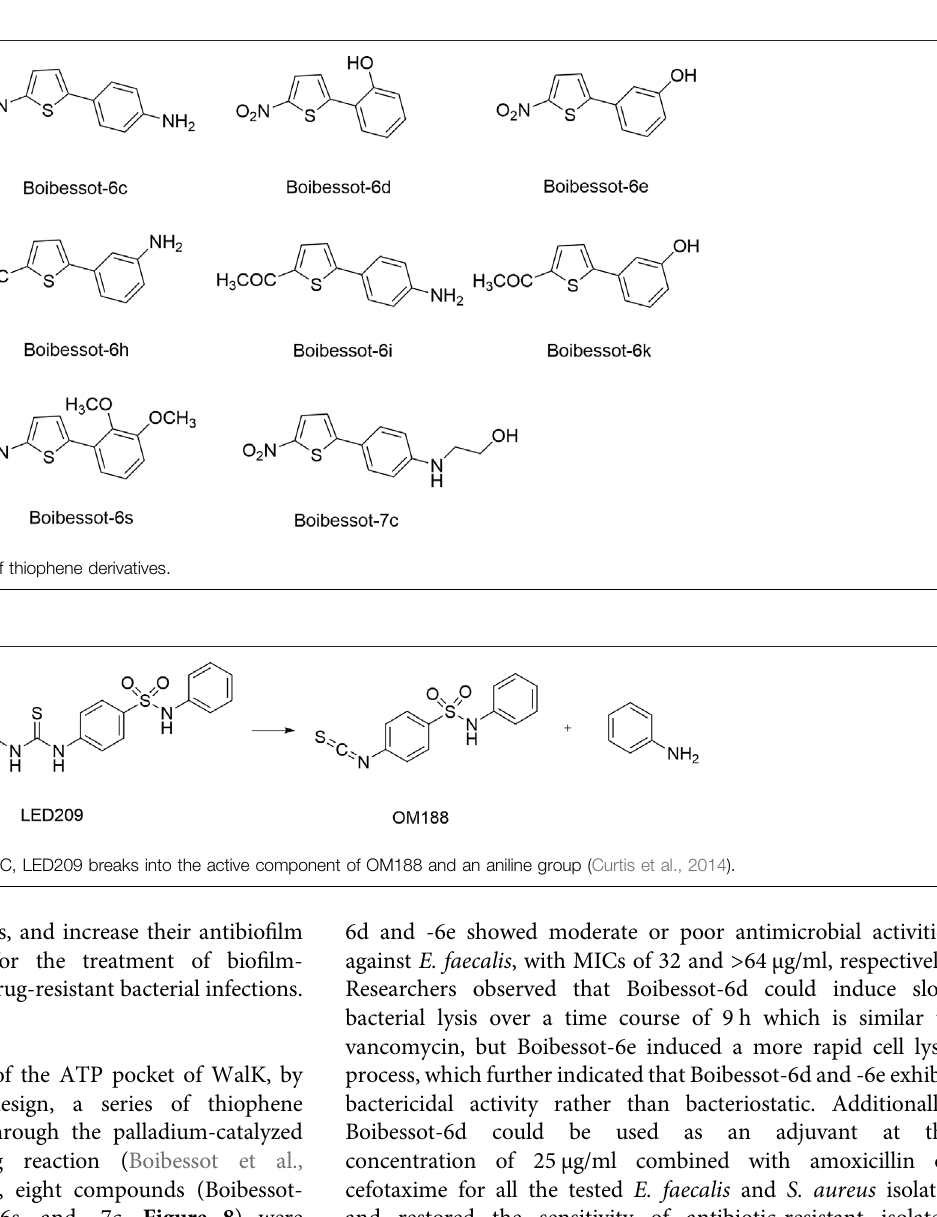
Frontiers in Chemistry |